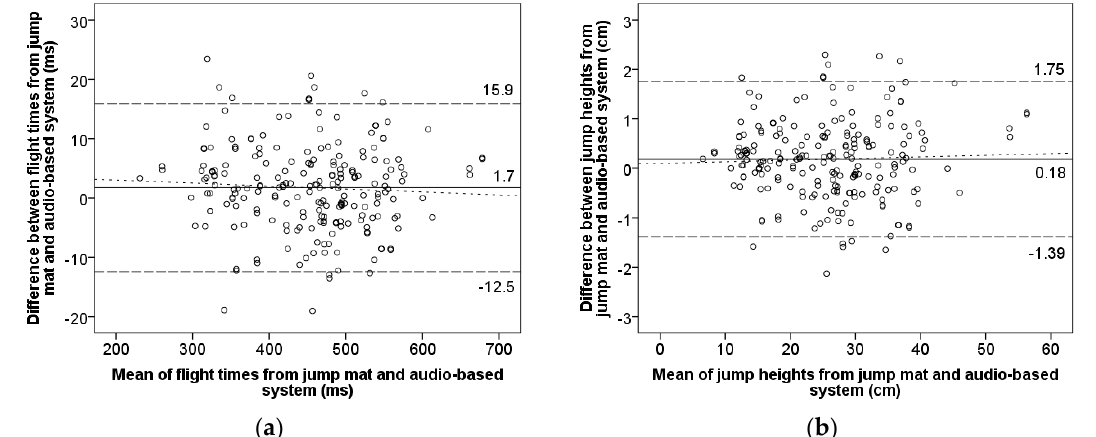
Figure 6. Bland–Altman plots for the measurements of the jump mat system and audio-based system. The solid central line represents mean between instruments (systematic bias); upper and lower dashed lines show a mean ± 1.96 SD (random error); the dotted line shows regression (proportional bias). ( a ) Flight time: regression y = –0.005x + 4 ms, r 2 = 0.003; ( b ) Jump height: regression y = 0.003x + 0.1 cm, r 2 = 0.002.